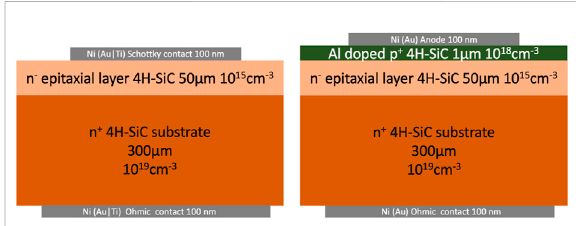
FIGURE 2 Schematic layout of two SiC detectors. The represented materials,thicknesses,dopingtypeanddensitiesaretypicalforthis kind of device, though they can vary depending on the speci fi c case. Left: Scheme of a SiC Schottky diode. The represented detector has four layers (from bottom to top): a Ni thin layer (usually prepared by thermal vacuum evaporation) forming the ohmic back electrode; a n + heavily doped conducting substrate wafer; a n − layer of high-quality lightly doped epitaxial material, usually grown by CVD technology (Par. 3.1.2); and a Ni thin layer forming the Schottky electrode. Right: Scheme of a